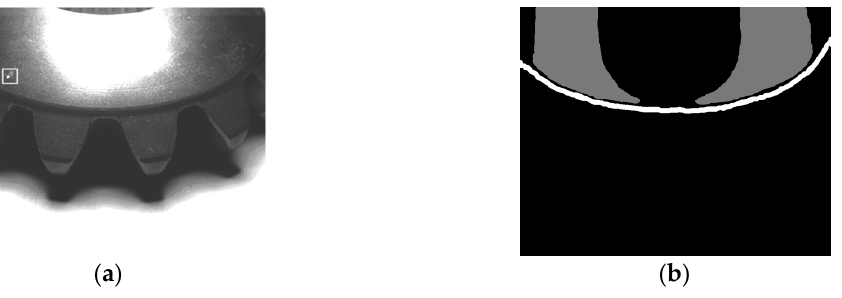
Figure 20. ( a ) The lateral image of sphere surface; ( b ) The template of sphere surface.